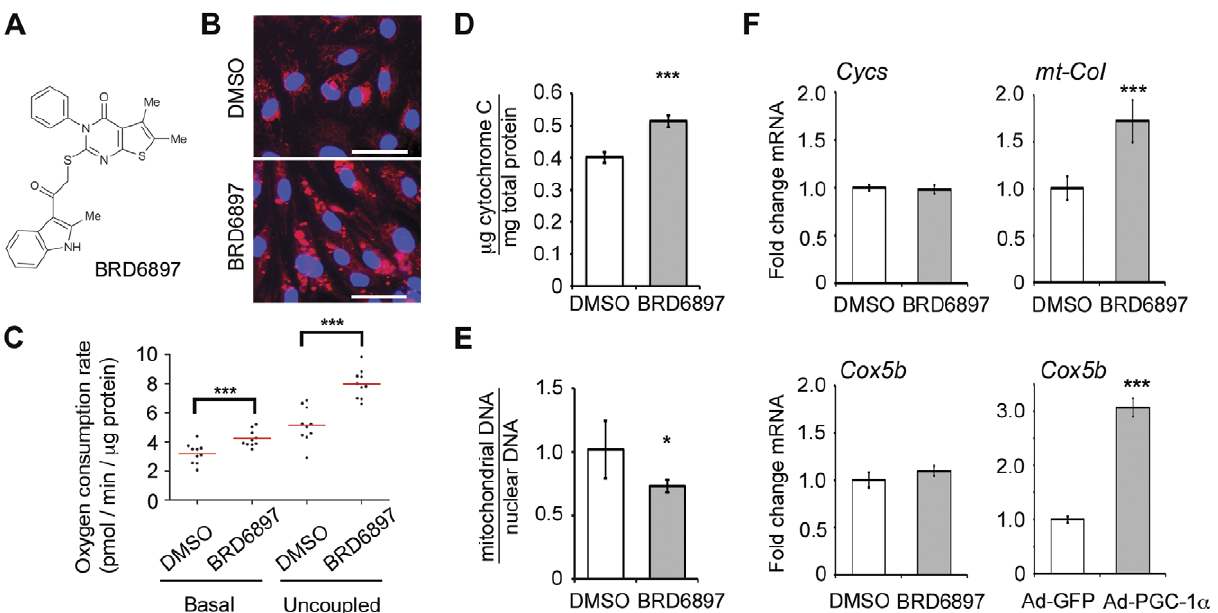
Figure 3. Effects of BRD6897 on mitochondrial content, gene expression, and physiology. ( A ) Chemical structure of BRD6897. ( B ) Images of DMSO- and BRD6897-treated HUVEC stained with Hoechst (blue) and MitoTracker (red). Scale bar: 50 m m. ( C ) Basal and uncoupled respiration of HUVEC treated for 3-days with 10 m M BRD6897. ( D ) Cytochrome C protein level detected by ELISA normalized to total protein content after 3-day treatment with 10 m M BRD6897. ( E ) Ratio of mitochondrial to nuclear DNA copy number after 3-day treatment with 10 m M BRD6897. ( F ) qPCR analysis of OXPHOS genes upon 3-day BRD6897 treatment. mtOXPHOS (mt-CoI) and nuclear encoded OXPHOS genes (Cycs, Cox5b) were profiled. As a positive control for activation of mitochondrial biogenesis program, PGC-1 a was over-expressed for three days and compared to GFP over- expression for three days. Changes in treatment relative to control were analyzed with unpaired t-test. * p , 0.05, ** p , 0.01, *** p , 0.001.